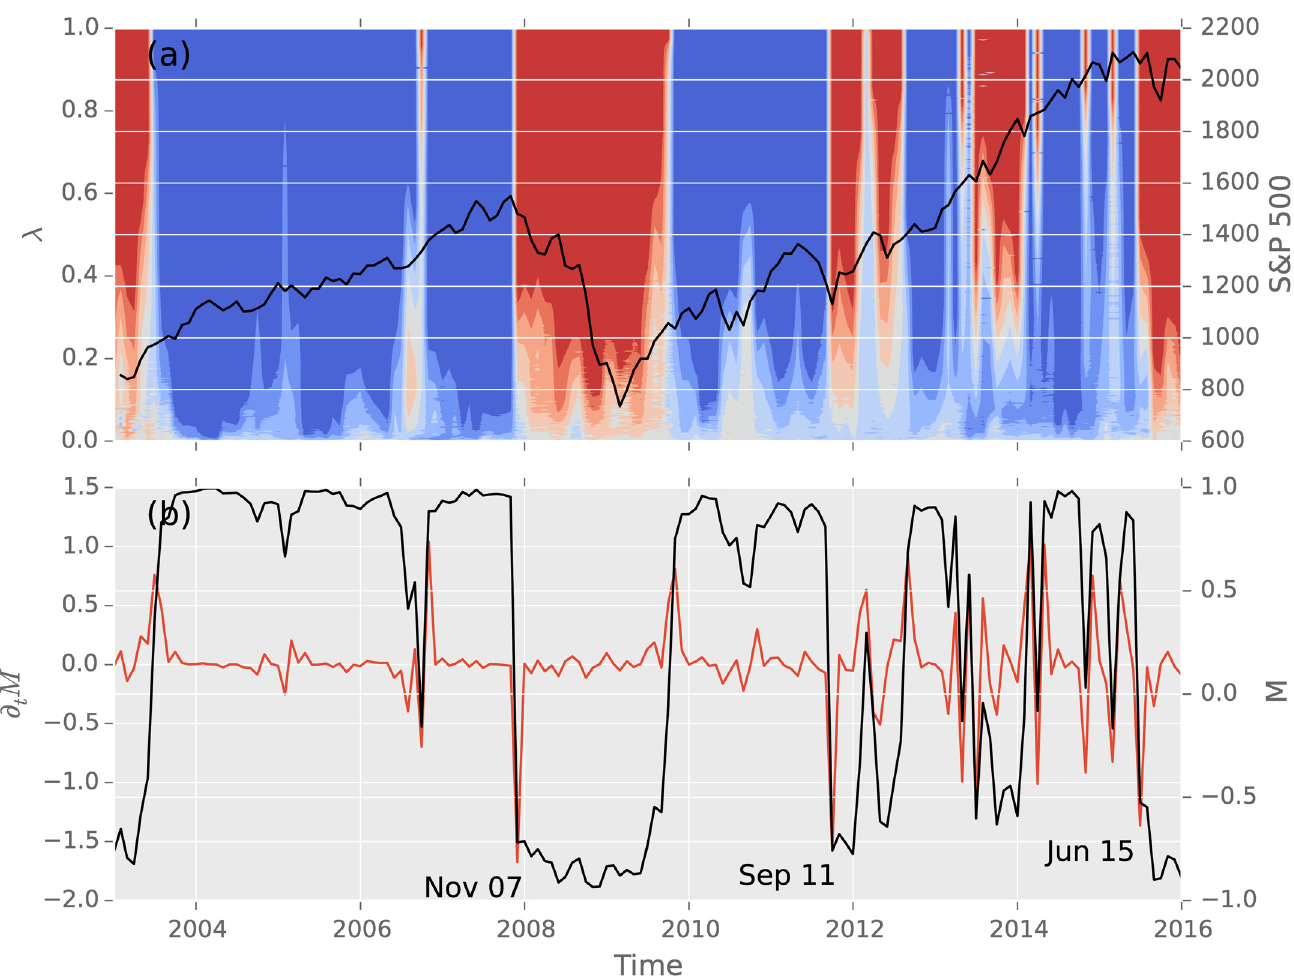
Fig 3. Comparison of the average investing strategy and its recordings with the S&P 500 index, in the ω = 12 months time-horizon. (a) shows the heat-map with varying risk level λ on the left y-axis and the logarithmic values of the S&P 500 index on the right y-axis. (b) shows on the left the changes in the average investing strategy (right y-axis). The slumps in November 2007, September 2011 and June 2015 fall in the times of sub-prime/ financial crisis, EURO-Zone debt crisis and Chinese stock market